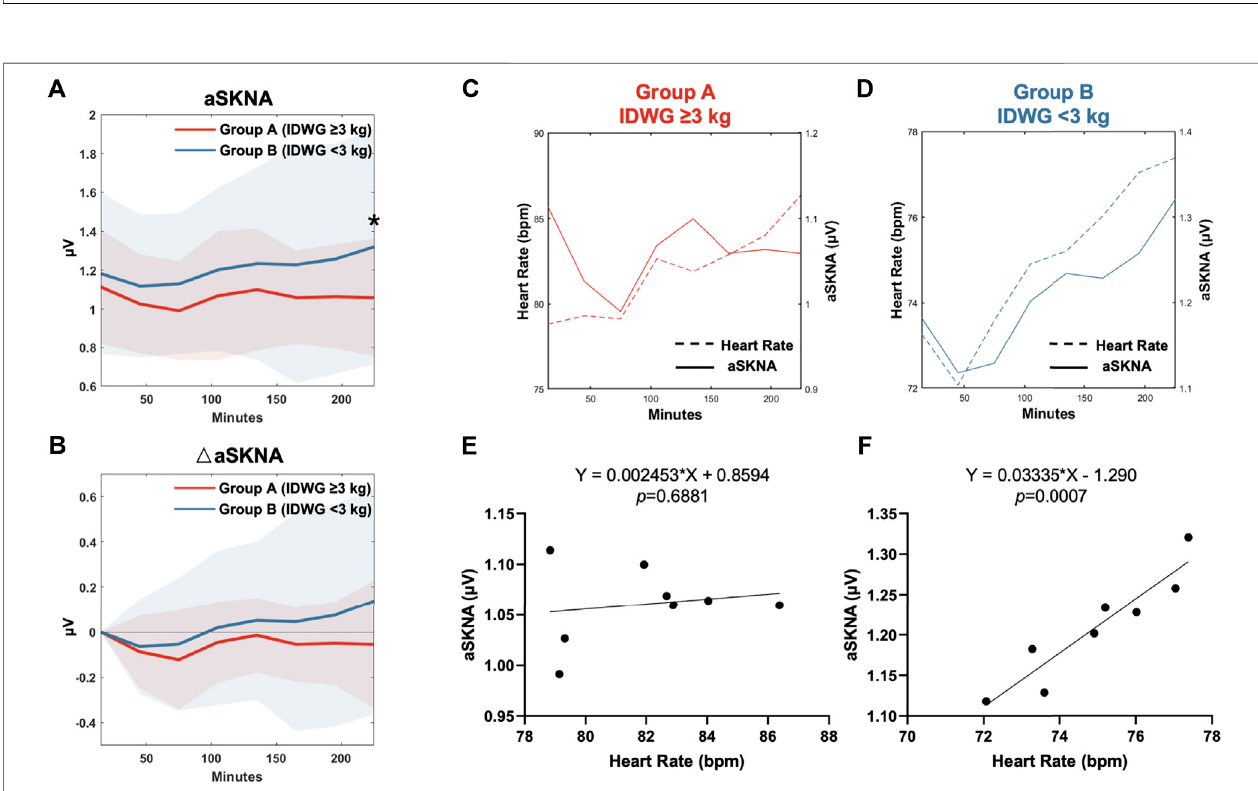
FIGURE 2 | The overall trend of physiological measurements during 4-h hemodialysis. Systolic blood pressure, diastolic blood pressure, mean heart rate, average skin sympathetic nerve activity, and representative HRV indices (SDNN, LF/HF, SD1/SD2, SampEn) were demonstrated. “ * ” stands for statistically signi fi cant ( p < 0.05) by one-way repeated measures ANOVA adjusted by Bonferroni ’ s multiple comparisons test ( vs the baseline). Error bars stand for the standard error of the mean (SEM).